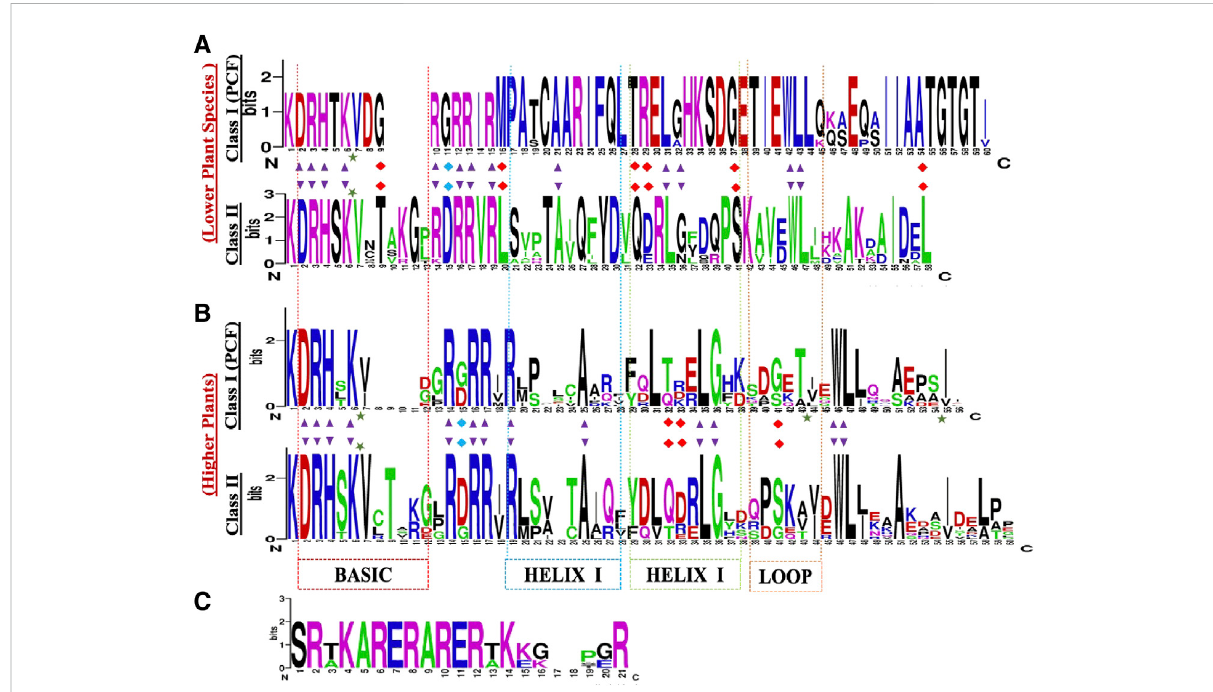
FIGURE 2 TCP protein sequence domain logos in: (A) lower plants (B) higher plants, (C) The angiosperm speci fi c R-domain, present in the CYC/ TB1 subclade. The sequence logos were generated by WebLogo online tool (http://weblogo.berkeley.edu/), based on the alignments of the TCP domains. The overall height of each stack letter indicates the sequence conservation at that position (measured in bits), whereas the height of the symbols within the stack re fl ects the relative frequency of the corresponding amino acid at that position. The black arrow depicts 90% conserved loci within the whole family. The red arrow depicts the key DNA binding site for the two subgroups. Top logo shows the TCP domain conserved within the lower plants. Bottom logo shows the TCP domain the higher